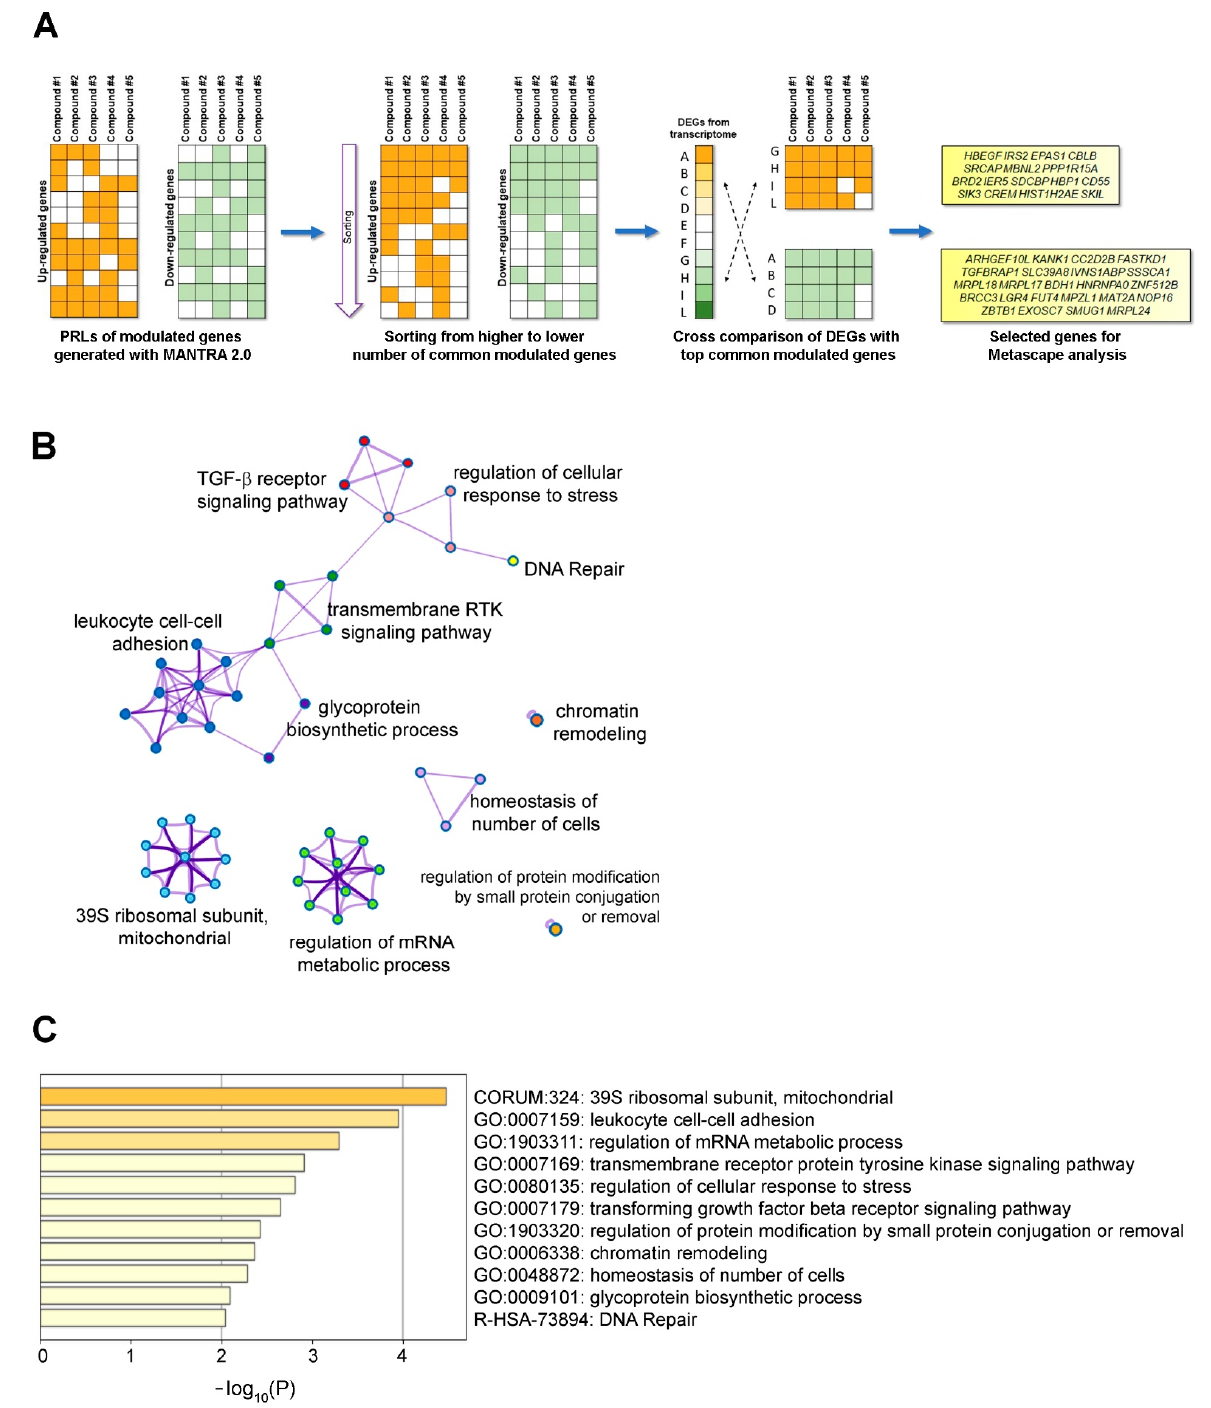
Figure 5. Post hoc analysis of DEGs of CTNS −/− ciPTECs. ( A ) The first step of the pipeline is a schematic representation of the MANTRA output, with the prototype ranked list (PRL) of genes potentially up- or downregulated by each compound; then, lists of genes are organized in order to have at the top those modulated from the highest number of compounds; finally, it was selected upregulated genes, and simultaneously modulated from at least four compounds, which have the downregulated counterpart in the list of DEGs obtained from transcriptome, and vice versa. Identified genes are analyzed with web application Metascape. ( B ) Network of enriched terms where each node represents an enriched term that is colored by its cluster ID and the thicker of edge link represents their similarity. ( C ) The bar graph lists the top 11 clusters with their representative enriched terms; color scale is proportional to the statistical significance of the